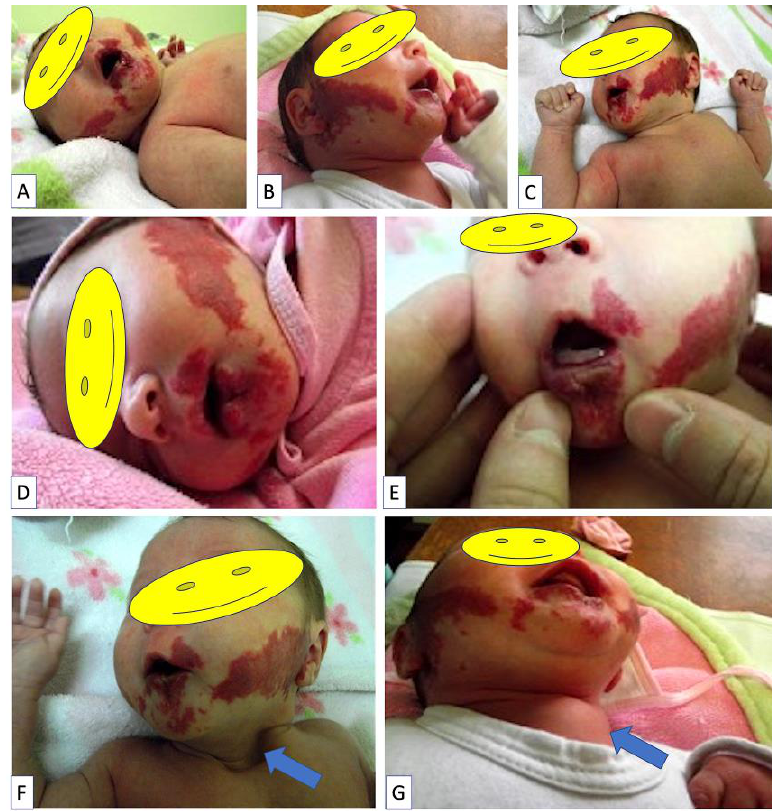
Figure 1. Clinical evaluation data of one month old baby girl admitted to hospital for multiple facial hemangiomas ( A ) distributed on the lower part of the face at mandibular region (right, ( B ) and left, ( C )) and on upper ( D ) and lower ( E ) lip. Note a massive ulceration of lower lip hemangioma ( E ). A sternal cleft was observed in association with facial hemangiomas, ( F ) better visible when baby is crying ( G ).